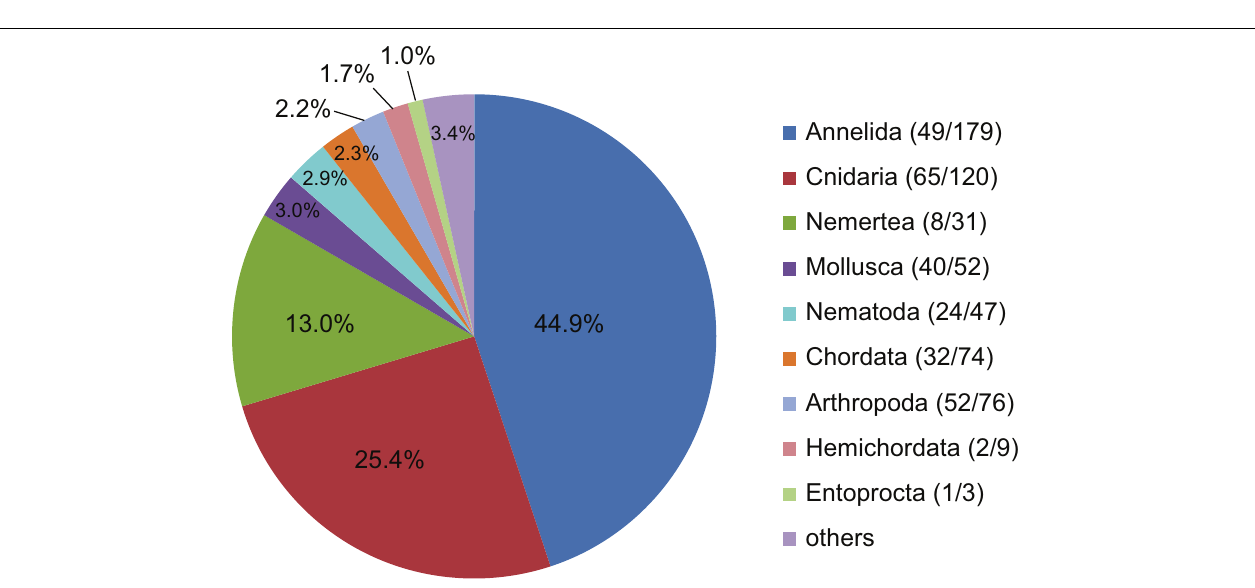
FIGURE 4 | Proportions of metazoan phyla detected by all the sequences of Data Set 1 (including 28S, 18S V1-2, and 18S V9). Numbers in brackets represent the number of metazoan families/OTUs found in each phylum.